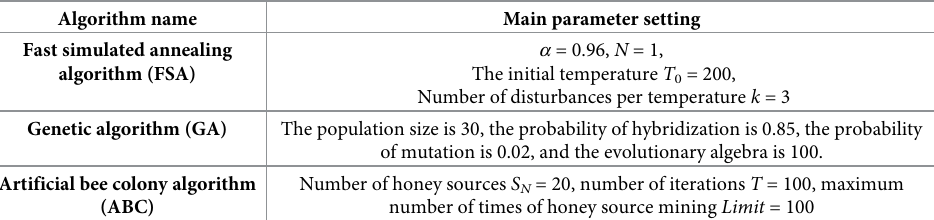
Table 2. Parameter setting situation.